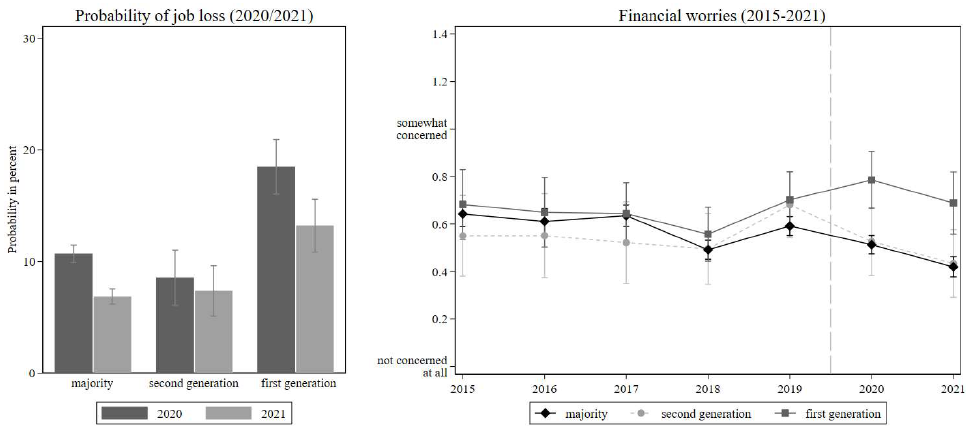
Figure 1. Developments of subjective job insecurity over time. Sources: SOEP-CoV waves 1 and 2, SOEP v36.1, weighted.